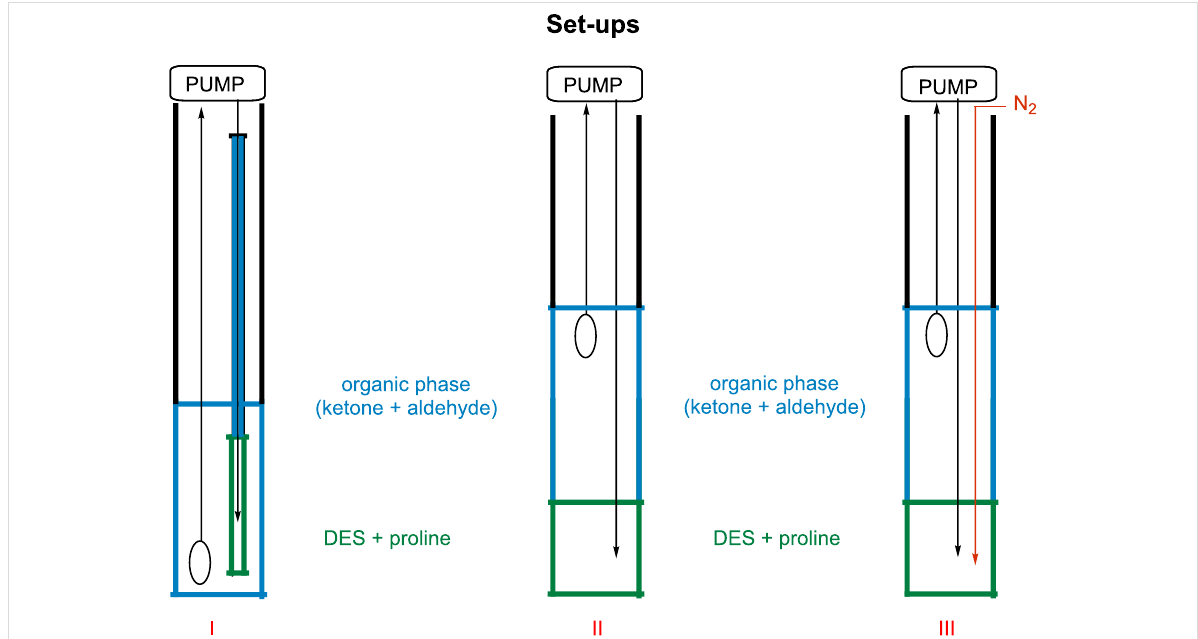
Figure 1: Experimental set-up I: test tube ( d = 0.5 cm); flow 1 mL/min; DES (1.5 mL); L-proline/DES = 130 mg/mL. Experimental set-up II: test tube ( d = 2.5 cm); flow 1 mL/min; DES (1.5 mL); L-proline/DES = 130 mg/mL. Experimental set-up III: test tube ( d = 2.5 cm); flow 1 mL/min; DES (1.5 mL); L-proline/DES = 130